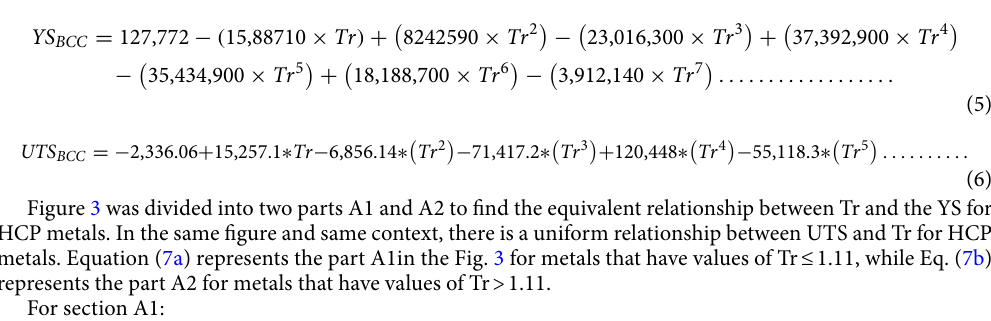
Figure 3 was divided into two parts A1 and A2 to find the equivalent relationship between Tr and the YS for HCP metals. In the same figure and same context, there is a uniform relationship between UTS and Tr for HCP metals. Equation (7a) represents the part A1in the Fig. 3 for metals that have values of Tr ≤ 1.11, while Eq. (7b) represents the part A2 for metals that have values of Tr > 1.11. For section A1: